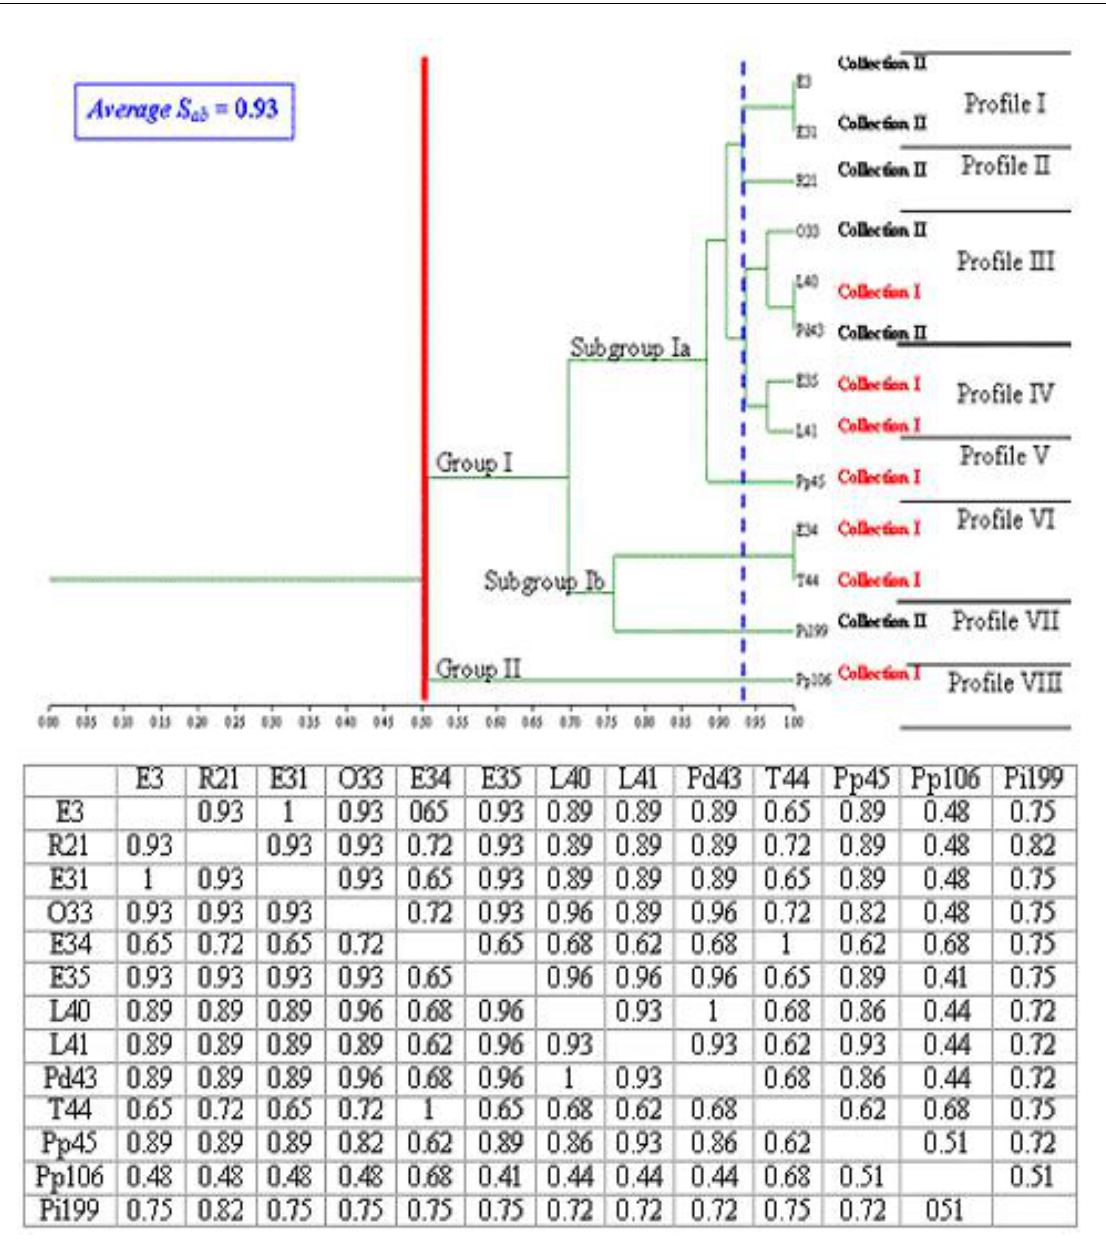
Figure 3 . Dendrogram based on S developed from RAPD-PCR standards of Klebsiella oxytoca with primer Operon 18 using the simple-matching coefficient. S